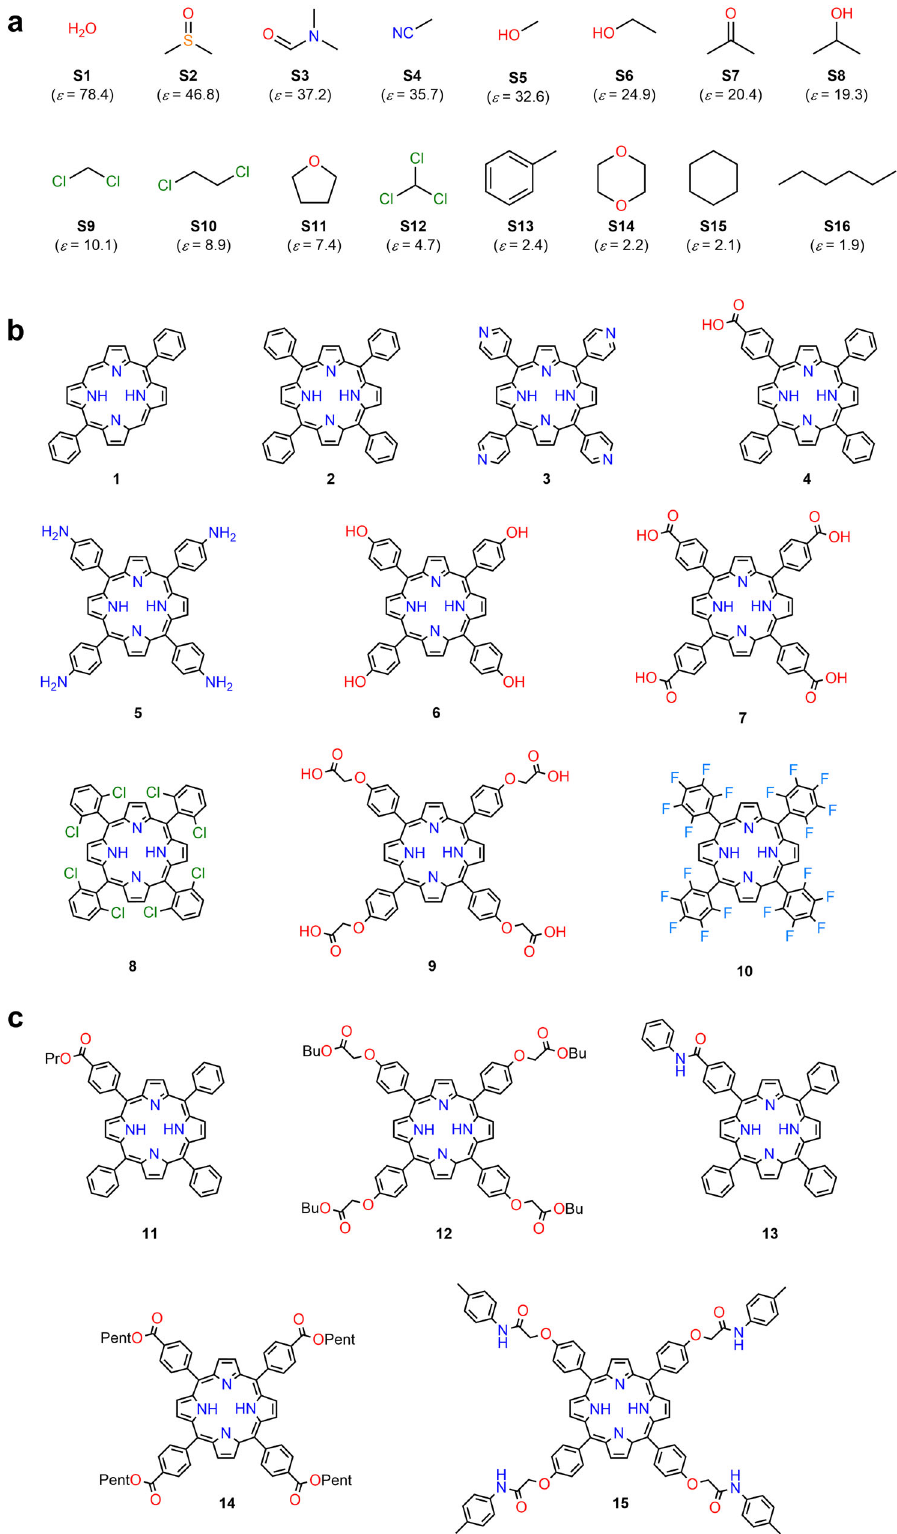
Fig. 2 Structures of solvents and TPP derivatives in this study. a Solvent list with dielectric constant ( ε ) considered from values for solvent model (SCRF) of Gaussian 16 79 : S1 : water, S2 : dimethyl sulfoxide, S3 : N , N -dimethylformamide, S4 : acetonitrile, S5 : methanol, S6 : ethanol, S7 : acetone, S8 : 2-propanol, S9 : dichloromethane, S10 : dichloroethane, S11 : tetrahydrofuran, S12 : chloroform, S13 : toluene, S14 : 1,4-dioxane, S15 : cyclohexane, and S16 : n -hexane. b Chemical structures of molecules in ACCESSIBLE ( 1 – 10 ). c Five synthesized TPP derivatives with highest priorities from GENERATED ( 11 – 15 ). For GENERATED, molecules are listed in order of priority ( 11 is highest priority). All 15 molecules ( 1 – 15 ) covered 24.8% of